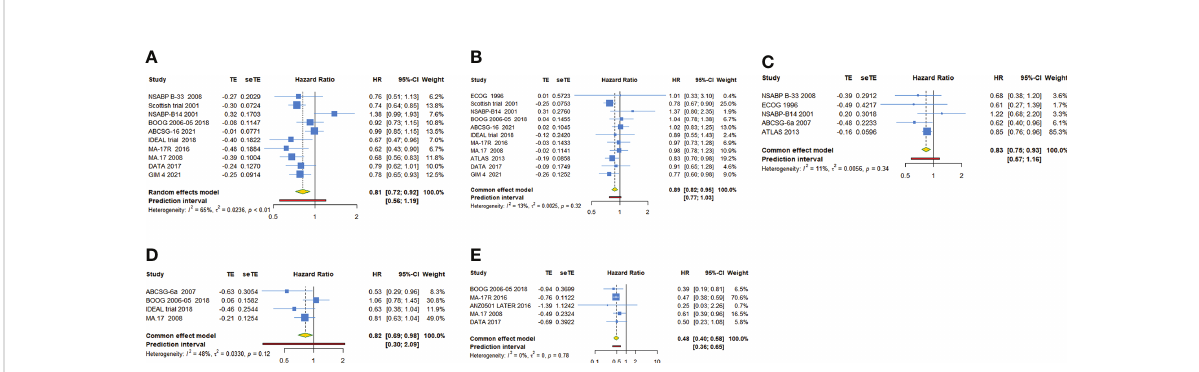
FIGURE 2 Forest plot of meta-analysis of extended adjuvant endocrine therapy for (A) disease-free survival, (B) overall survival, (C) relapse-free survival, (D) distant metastatic-free survival, and (E) new breast cancer cumulative incidence.